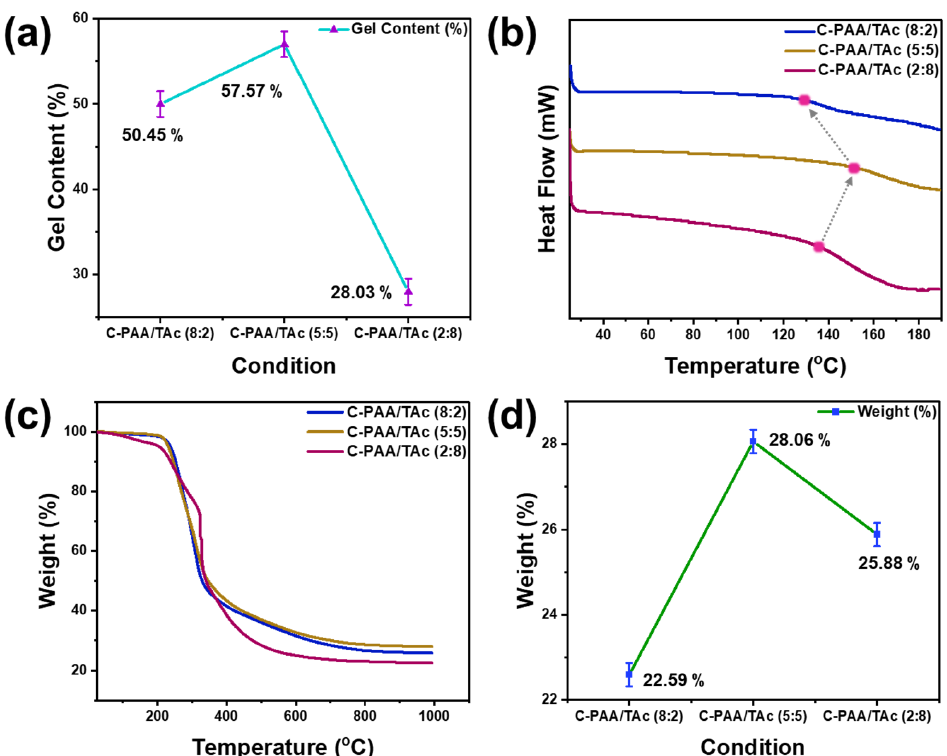
Figure 3. ( a ) Gel contents of C-PAA/TAc (8:2), C-PAA/TAc (5:5), and C-PAA/TAc (2:8); ( b ) DSC thermograms; ( c ) TGA thermograms; ( d ) final weight based on TGA. The TGA results show that C-PAA/TAc (5:5) and C-PAA/TAc (2:8) exhibited